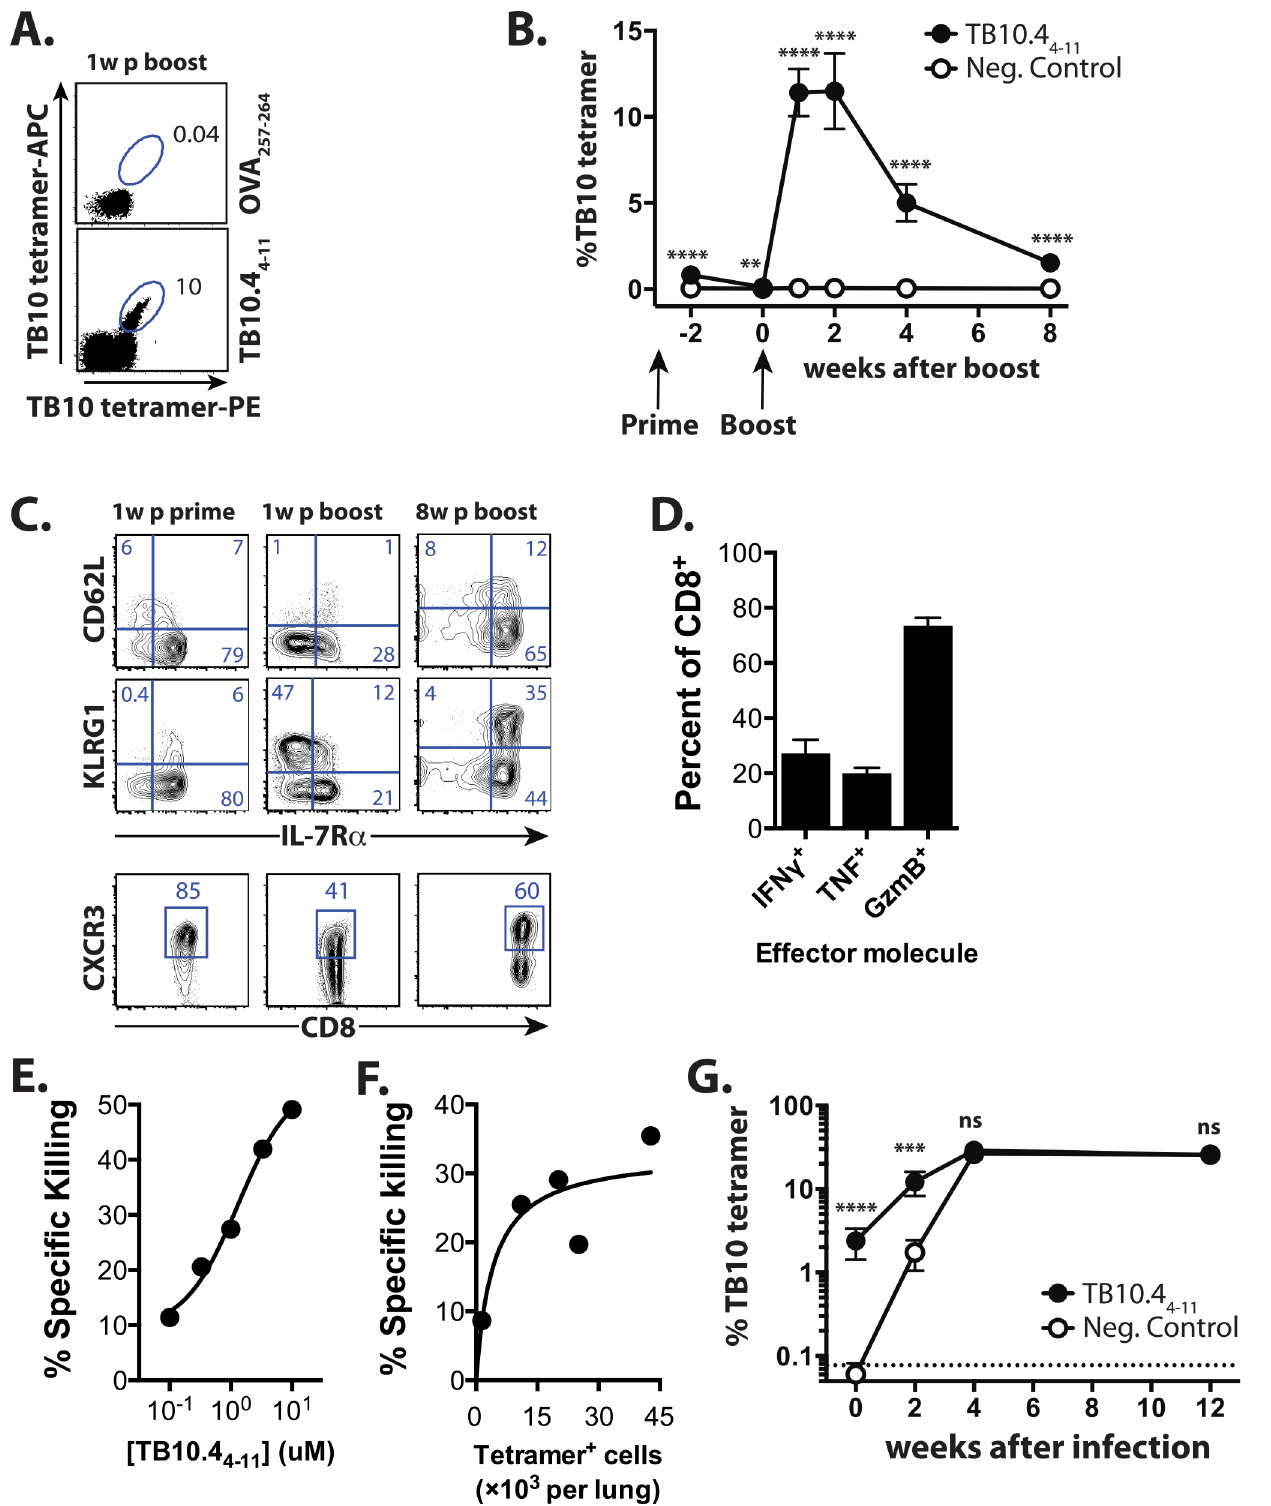
Fig 1. TB10 vaccination elicits memory CD8 + T cells that generate 2° effectors during Mtb infection. (a) The TB10 tetramer + response enumerated by duel-tetramer staining in blood 1 week post-boost with TB10 4-11 or Ova 257-264 (control) vaccination. Numbers indicate the % of CD8 + T cells. (b) TB10 tetramer + responses from blood after TB10 4-11 or control (B8R 20-27 or Ova 257-264 ) vaccination at time points post-boost. (c)